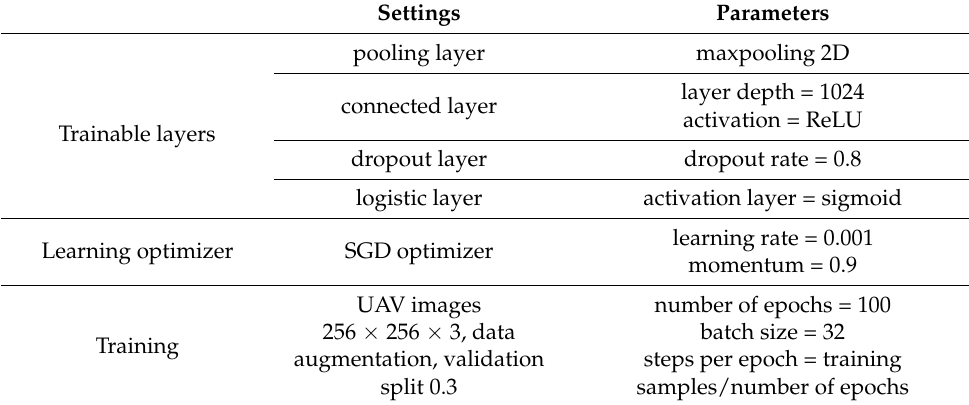
Table 3. Settings and adjusted parameters for our fine-tuned CNN based on the U-Net architecture.